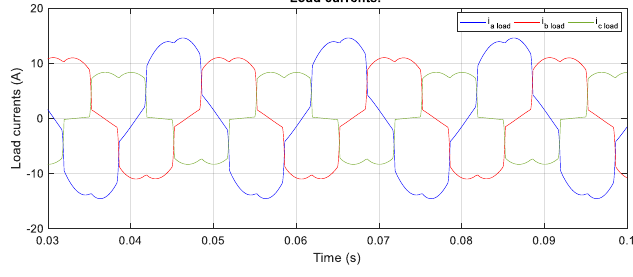
Figure 8. Load current waveforms. Electronics 2020 , 9 , x FOR PEER REVIEW